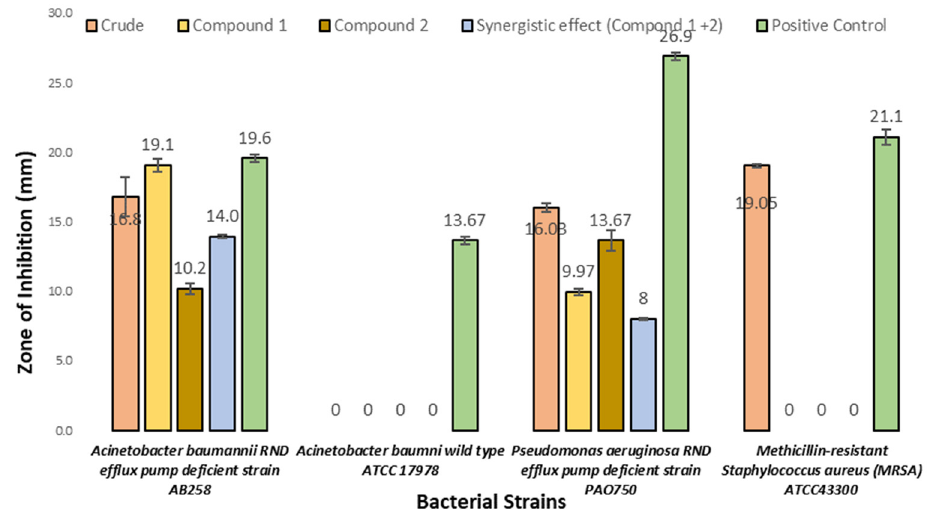
Figure 4. The average diameter of the zone of inhibition (mm) of the crude extract, compound 1 , compound 2 , the synergistic effect of compounds 1 and 2 , and the positive control (ciprofloxacin) against four clinical isolates of multi-drug-resistant bacterial strains. Data are presented as mean ± SD from three independent experiments, with a significance level of p < 0.05, versus the control group.